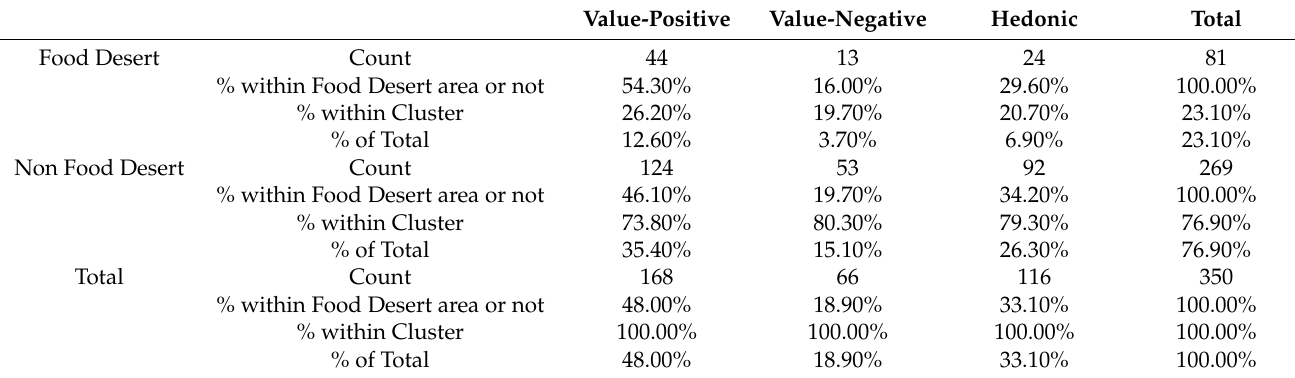
Table 10. Food desert and non-food desert by consumer